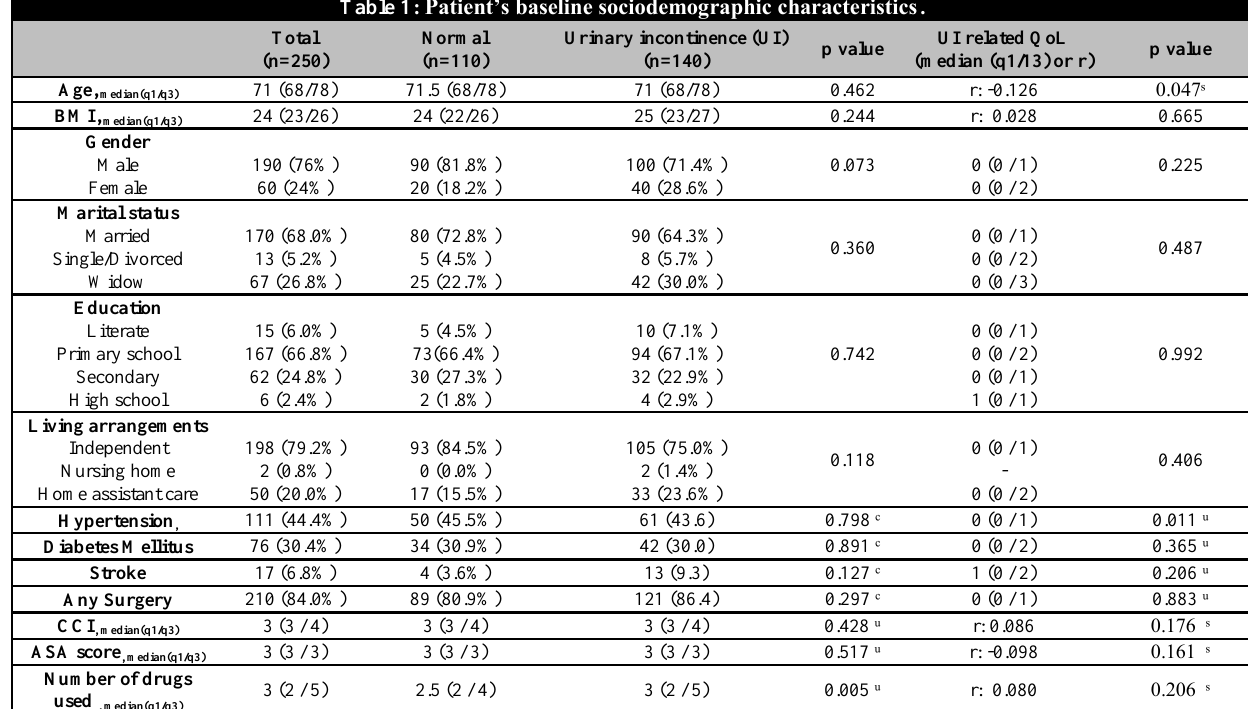
Table 1: Patient’s baseline sociodemographic